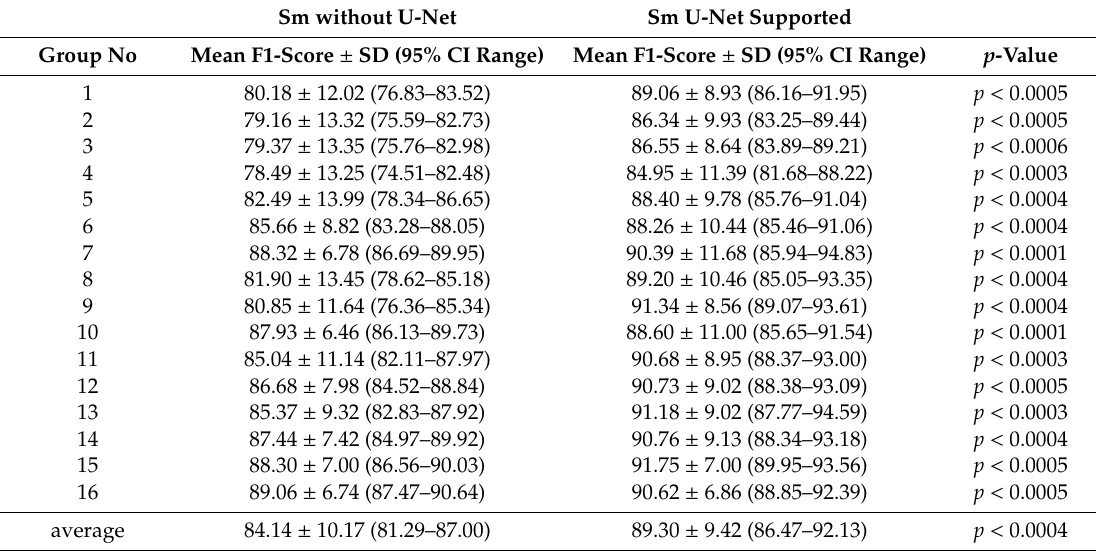
Table 2. Table showing the results of automatic kidney detection in the Ct images. The results were obtained by cross-validation calculating the F1-score for the system without U-Net and with the support of the U-Net network. Standard deviation (SD), confidence interval (CI) and p -value were calculated for each group.